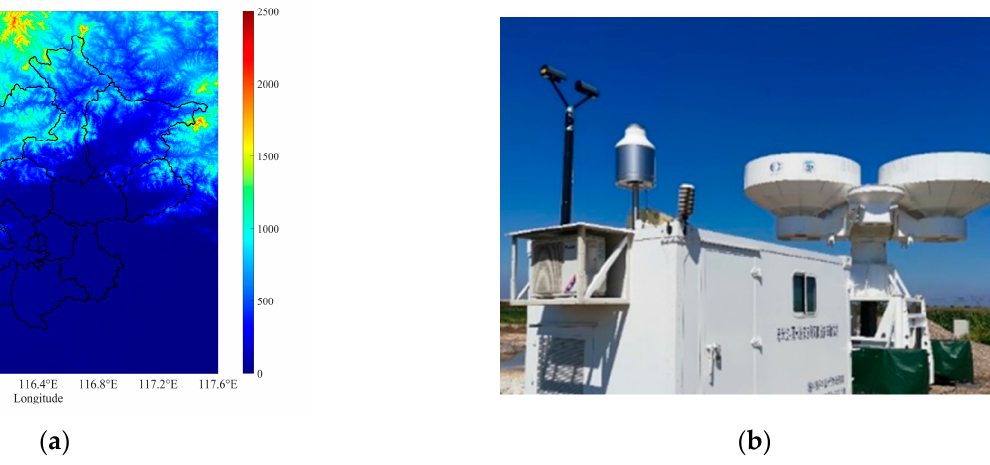
Figure 1. ( a ) Geographical location of Beijing joint winter snowfall observation experiment and ( b ) Snowfall observation apparatus.